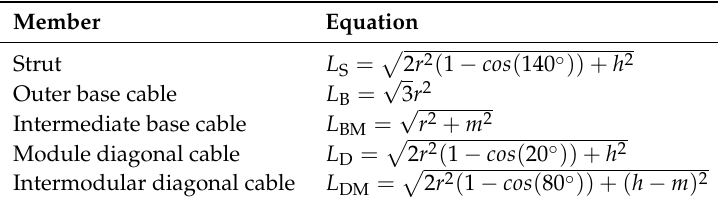
Figure 4. Overlapped simplex column—designations. Table 3. Overlapped simplex column—functions of the member